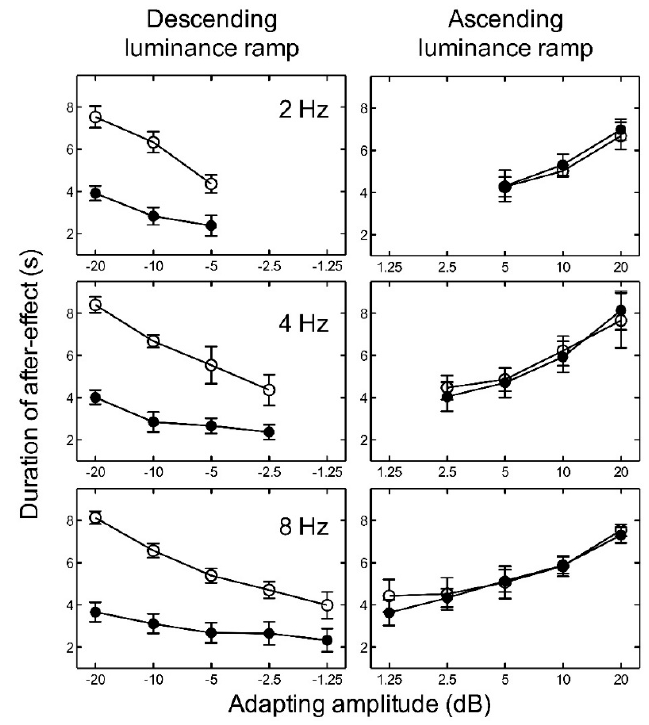
Figure 3. Experiment 1. The average duration of the aftereffect is plotted as a function of adapting luminance amplitude for high luminance (open circles) and low luminance (closed circles) with adapting frequencies of 2, 4, and 8 Hz. Luminance amplitudes greater than zero represent ascending ramps and negative values represent descending ramps. Error bars represent ± 1 SEM across the five observers. Table 1. Experiment 1. Two-way repeated measures ANOVA for adapting luminance ramp direction and ramp amplitude on the duration of the aftereffect at each temporal frequency at high luminance.